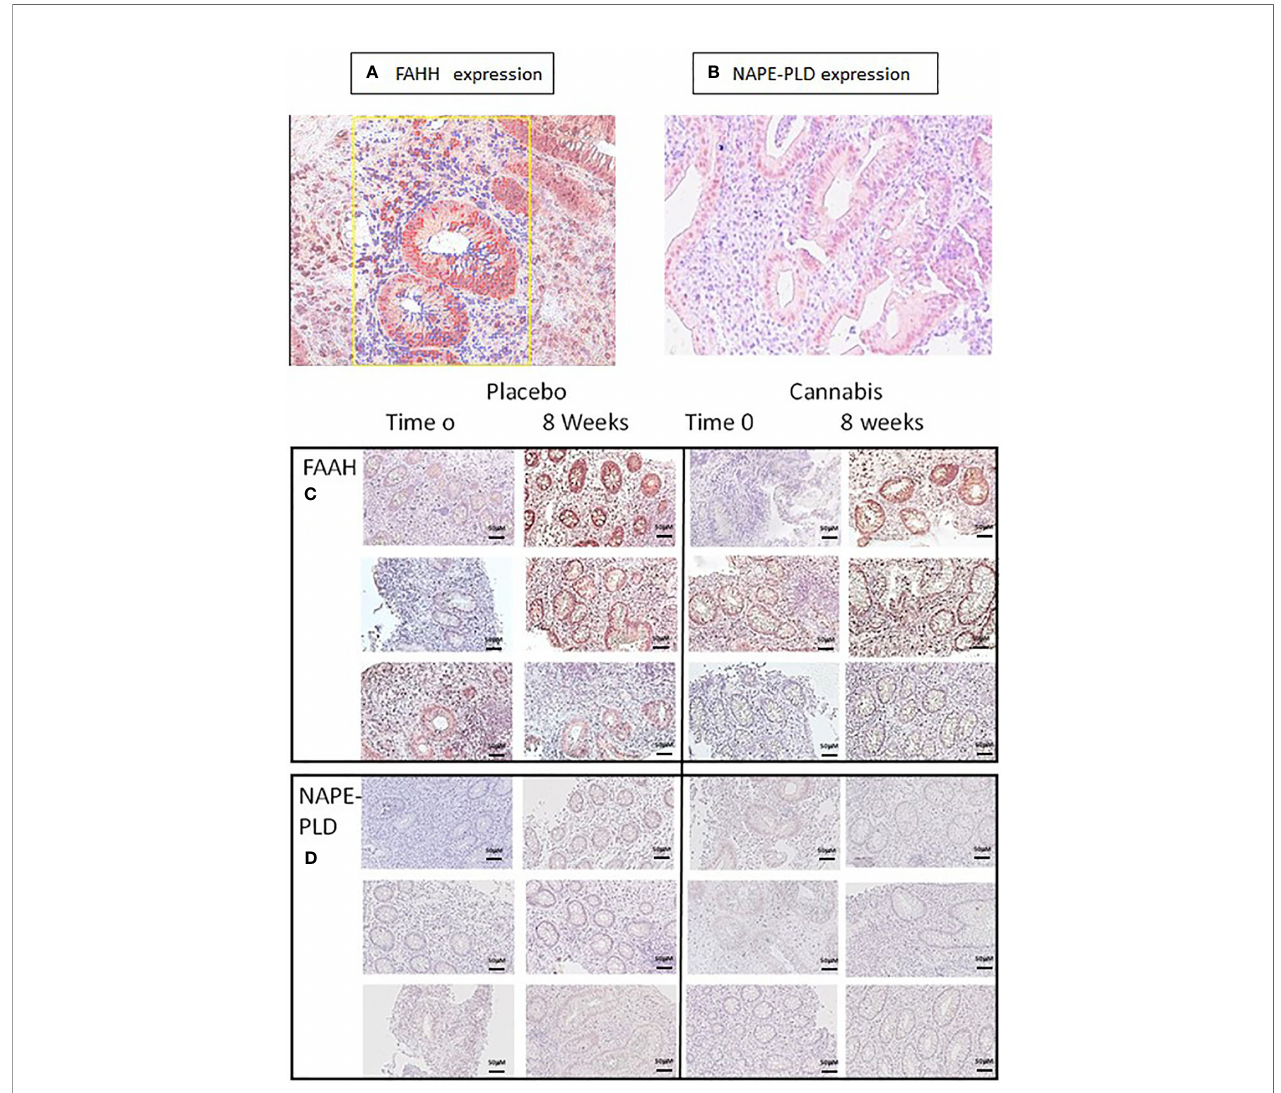
FIGURE 3 | FAAH and NAPE-PLD expression in colon biopsies. (A, C) FAAH and (B, D) NAPE-PLD expression were evaluated in colon biopsies using immunohistochemistry. The expression of the proteins in the images was measured using QuPath digital analysis tool. Presented are representative pictures of colon biopsies stained with (A) anti-FAAH and (B) anti-NAPE-PLD. The yellow square in panel (A) illustrates a QuPath reading. The red markings indicate a positive staining for FAAH, while the blue ones indicate staining with hematoxylin. (C, D) Images of FAAH and NAPE-PLD staining from three patients treated with placebo or cannabis at the beginning of the experiment and 8 weeks